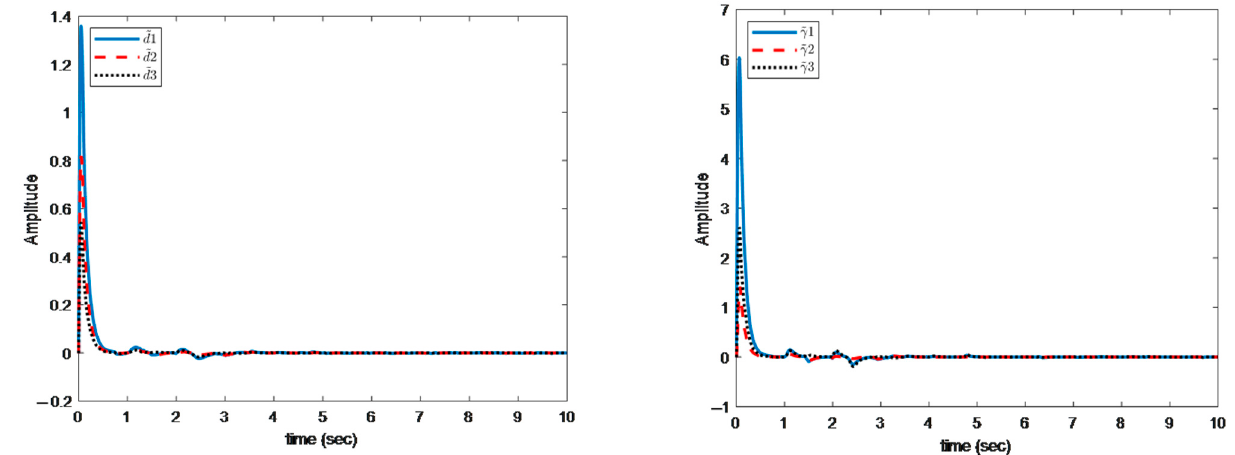
Figure-7. Error curves obtained for estimating the uncertain boundaries ( right ) and disturbances Figure 7. Error curves obtained for estimating the uncertain boundaries ( right ) and ( left ). disturbances ( left ).